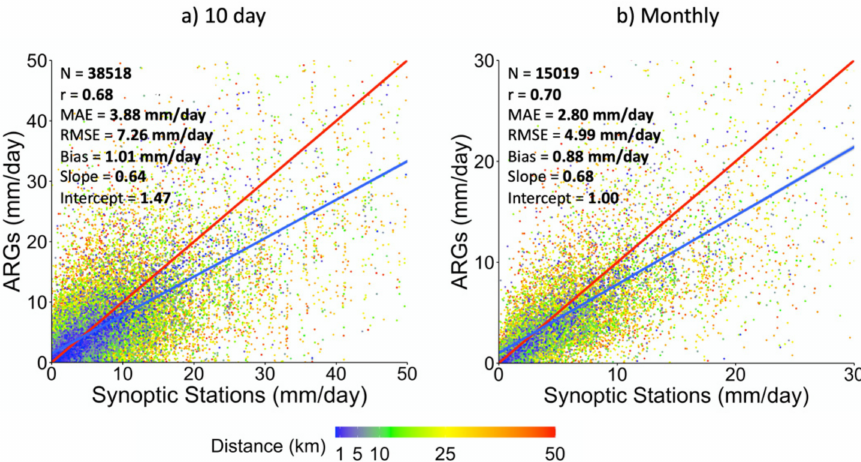
Figure 4. ARG rainfall measurements compared with synoptic station data using ( a ) 10 day and ( b ) monthly averages. The plots are color coded to indicate the distance between each ARG and the closest synoptic